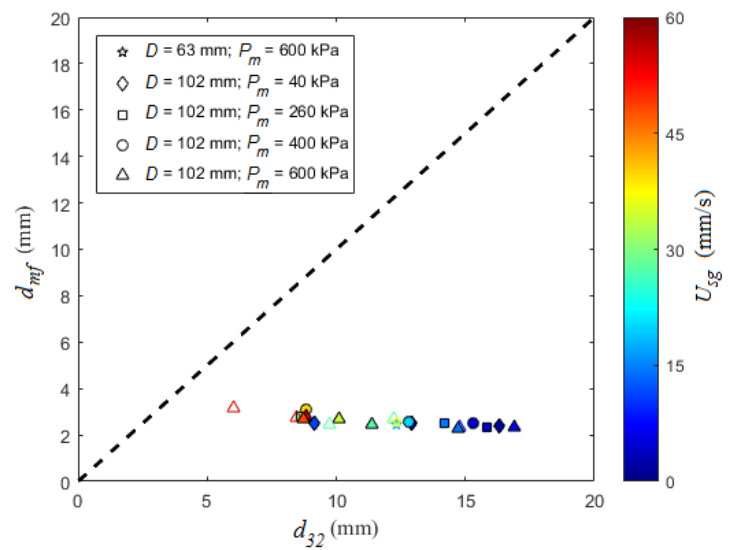
Figure 6. Comparison between the most frequent bubble size ( d mf ) and the Sauter mean diameter ( d 32 ). The dashed line corresponds to d mf = d 32 . Open and closed symbols correspond d inj = 0.8 and 1.6 mm, respectively.